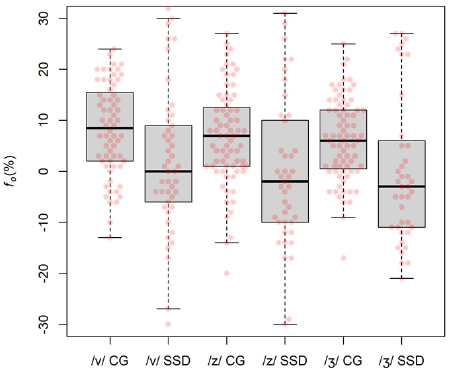
Figure 4. Predicted probability of observing weak-voiced fricatives for all observations ( left ), children without SSD ( middle ) and children with SSD ( right ), as a function of place of articulation. Relative f o measures shown in Figure 5, were also analysed.